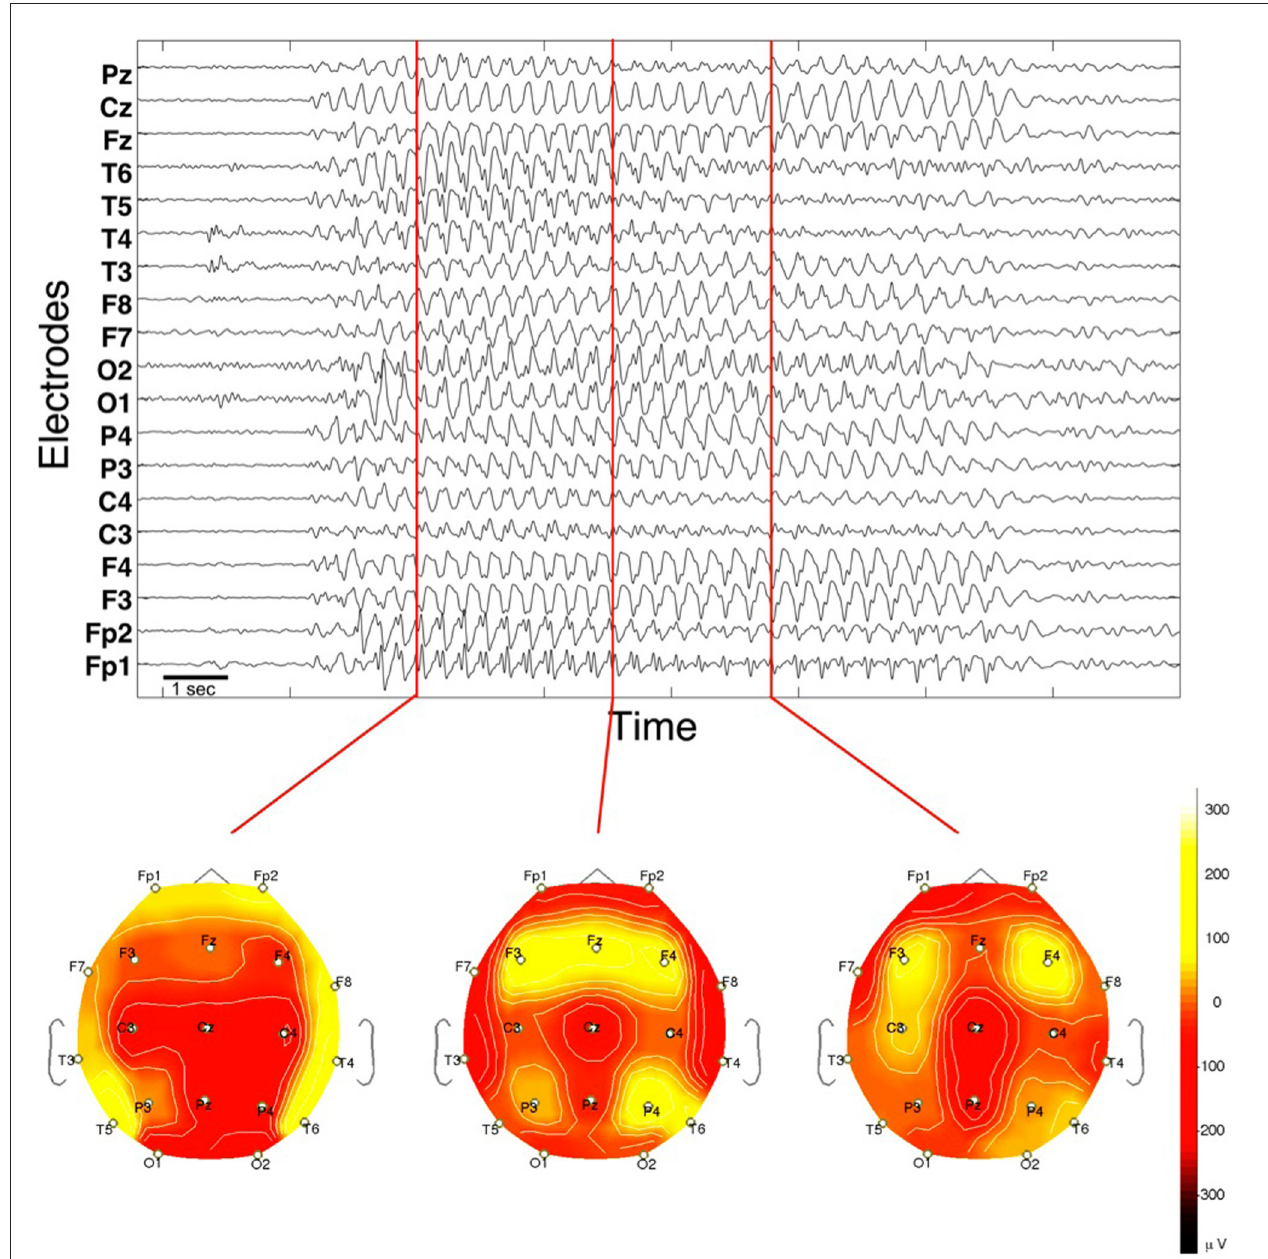
FIGURE 1 | EEG of a spontaneous absence seizure in a pediatric patient. Potentials from standard surface electrodes are plotted against time. Horizontal axis spans about 16s. Below are three topographic potential mappings projected on the scalp (seen from